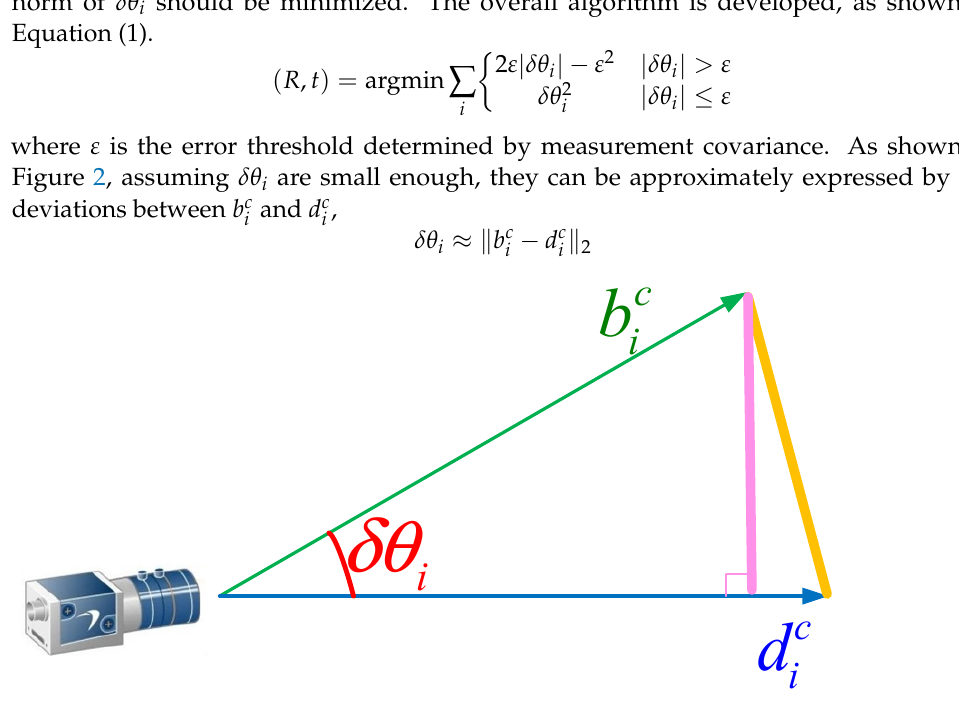
Figure 2. Approximation of δθ i . δθ i is enlarged to show the difference clearly. The approximation in our algorithm is colored in orange while the one in [21] is colored in pink.